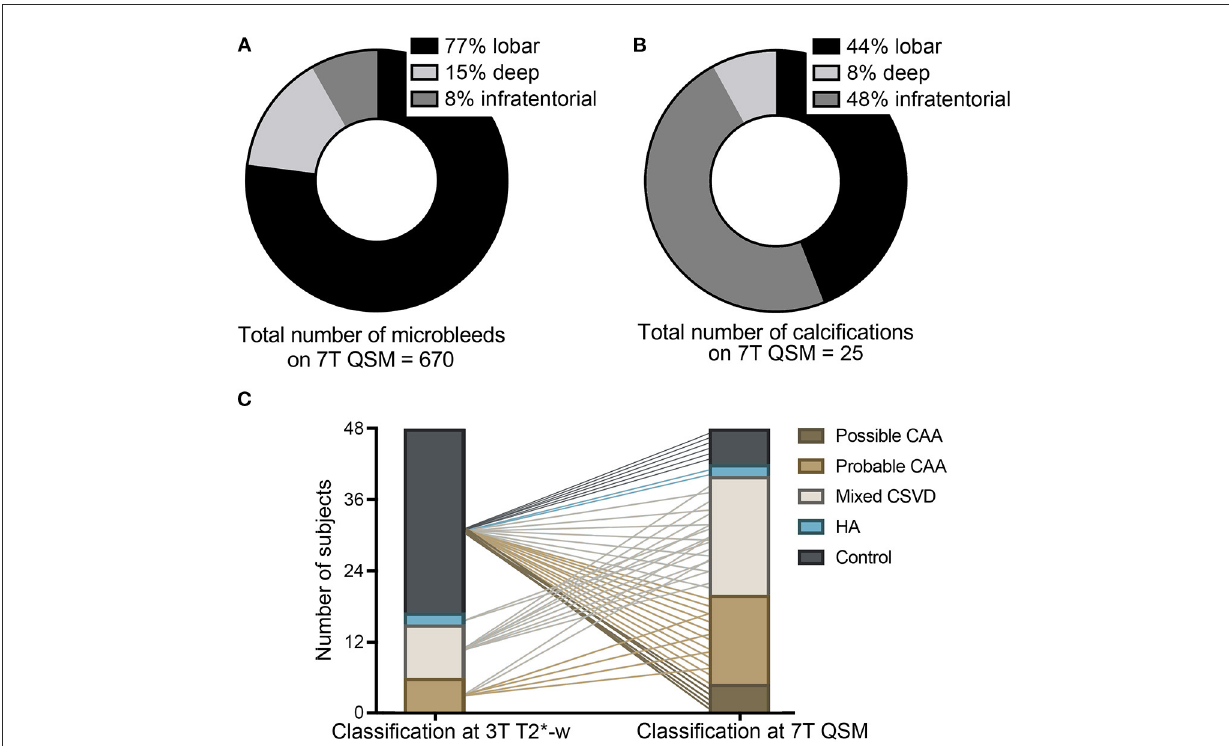
FIGURE4 Implications of the use of 7T QSM. Legend: Pie charts showing the localization of the total amount of microbleeds (MBs) in our study cohort, as detected on QSM (A) and of calcifications (B) , as detected on 7T QSM. Graph (C) elucidating the classification of study participants in the different subgroups at 3T T2*-w imaging and how 7T QSM would impact the neuroimaging-based classification due to the increased number of MBs detected and due to the calcifications. Possible and probable cerebral amyloid angiopathy (CAA, light and dark brown), mixed cerebral small vessel disease (CSVD, white), hypertensive arteriopathy (HA, blue), healthy controls without CSVD (gray) (C)